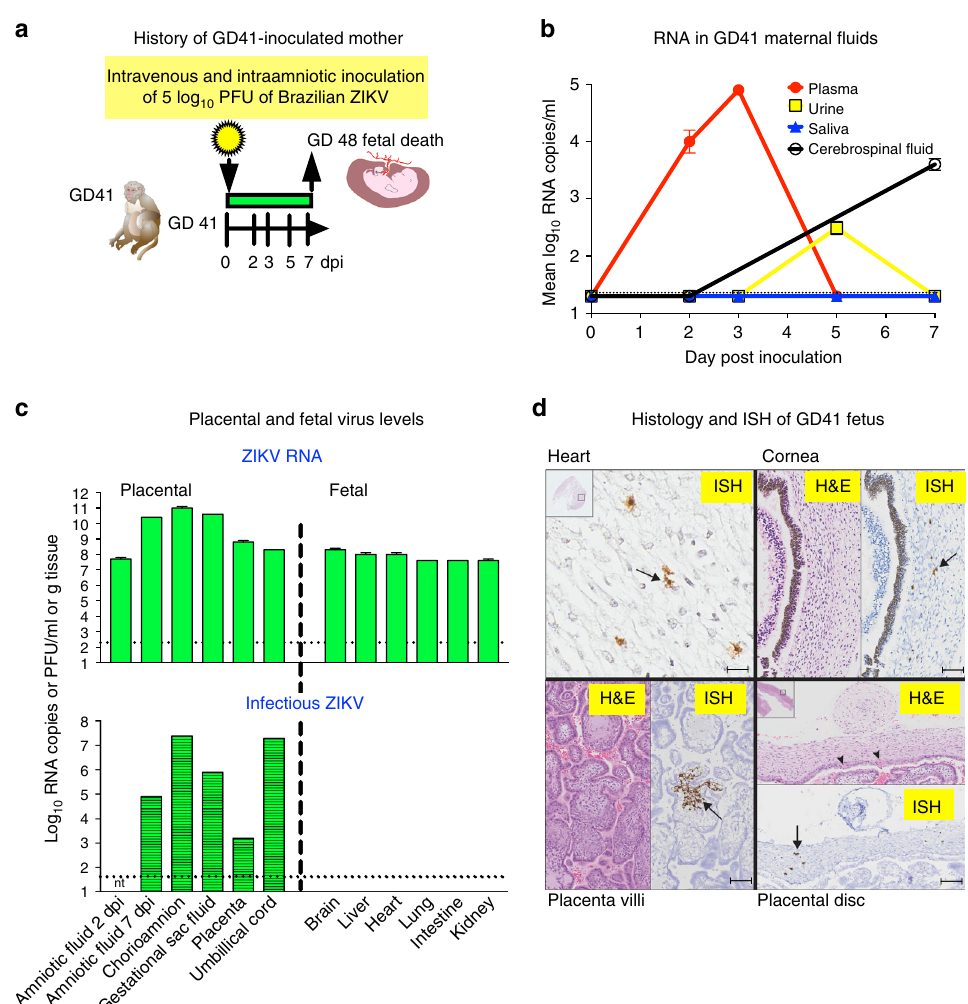
Fig. 3 ZIKV infection associates with early death of GD41 fetus. a Schematic representation of infection outcome that resulted in fetal death 7 dpi. b ZIKV RNA levels in maternal fl uids sampled by venipuncture, cystocentesis, saliva eluted from cotton swabs placed in the cheeks of macaques, or cervical spinal tap, reported in mean log 10 RNA copies/ml and assayed in triplicate with error bars showing standard deviations. The dotted line shows the LOD, 2.3 log 10 RNA copies/ml. c ZIKV RNA and infectious virus in placental and fetal tissues 7 dpi (except where noted for amniotic fl uid), detected in mean log 10 RNA copies assayed in triplicate or log 10 Vero cell plaque forming units (PFU) per ml or gram tissue. The dotted lines show the ZIKV RNA LOD of 1.3 log 10 RNA copies or the plaque assay LOD of 1.6 log 10 PFU per ml or gram tissue. Amniotic fl uid from 2 dpi was not tested (nt) by plaque assay. Error bars on RNA measures show standard deviations for three replicates. d Hematoxylin and eosin and in situ hybridization images of selected fetal tissues showing ZIKV RNA labeled brown and highlighted with arrows. Scale bars are as follows: heart, 54 μ m, cornea, 150 μ m, placenta villi, 130 μ m, placental disc, 200 μ